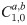
Disagreement between MCC and Kappa for C1,0a,b with a = 1, as function of b ≥ 0.If b > 1, the negative class is underrepresented and systematically misclassified, and the positive class is also mainly misclassified. (a) A zoom of the detail for b ≤ 2. (b) For b ≤ 30.